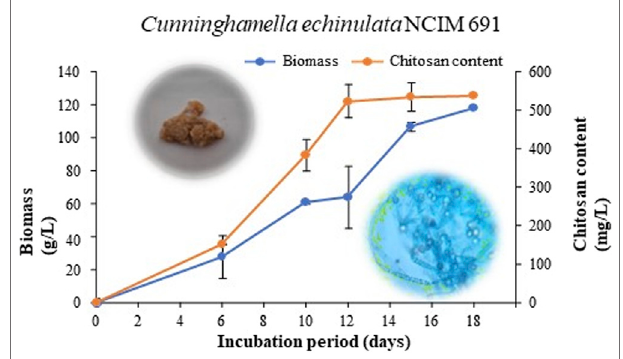
FIGURE 1 | Biomass and chitosan content of C. echinulata NCIM 691 grown in potato dextrose broth.